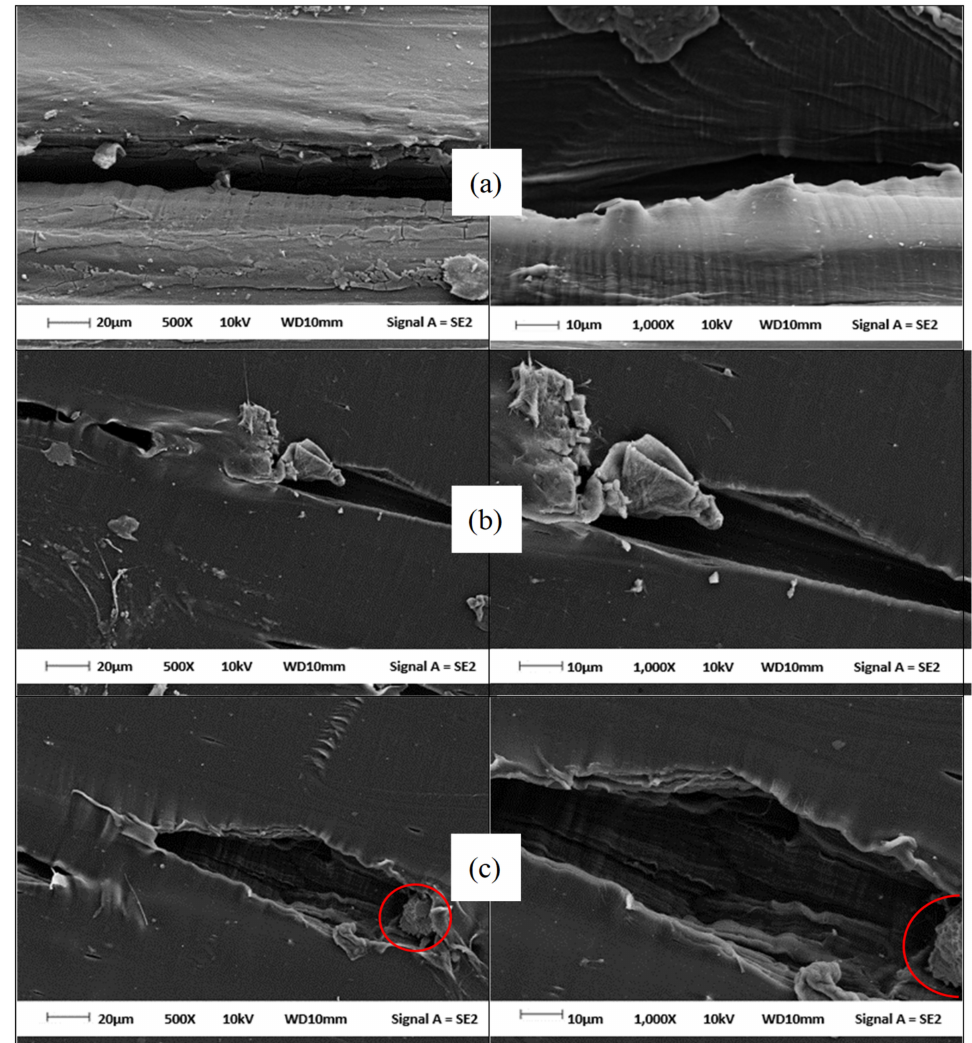
Figure 3. FESEM images of tensile-fractured surface of the ( a ) virgin PECoVA, ( b ) PECoVA/DOL3 and ( c ) PECoVA/OMCD3 composite at 500 × magnification ( left ) and 1000 × magnification ( right